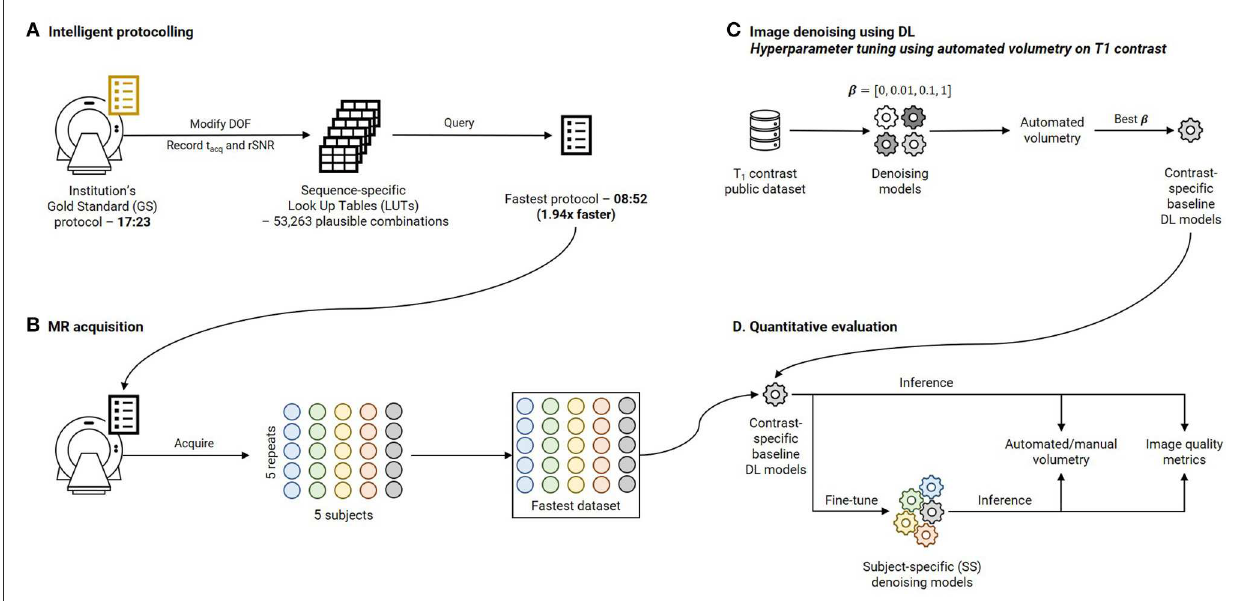
FIGURE1 Overview of this work. (A) Intelligent protocolling: specific acquisition parameters (Degrees Of Freedom, DOF, Table 1) were varied and acquisition duration (t acq ) and relative SNR (rSNR) values were recorded from the vendor-provided user interface. All these values were recorded to construct a sequence-specific Look Up Tables (LUTs). The “Fastest” protocol was assembled by querying these LUTs to obtain P acq for each sequence. (B) Five subjects were scanned using the Fastest protocol over five repeats to assemble the Fastest dataset. (C) Contrast-specific image denoising models were trained to improve image quality of the Fastest dataset. (D) Automated volumetry was performed for the T 1 -contrast denoising model, and manual volumetry for the remaining contrasts, to evaluate the performances. In addition, quantitative image quality metrics were